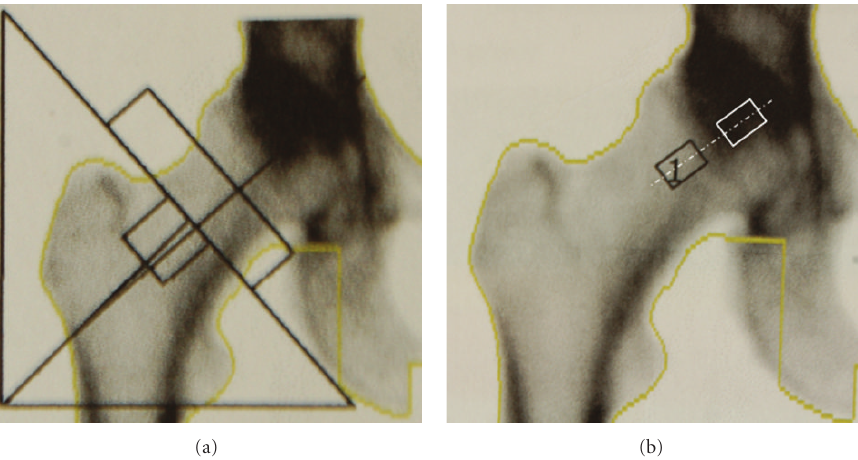
Figure 1: Standard BMD measurement of the patient femoral neck using DXA (a). Bone sample position for in vivo measurement of the bone sample (black) and the position of the retrieved cancellous bone sample (white) (b).